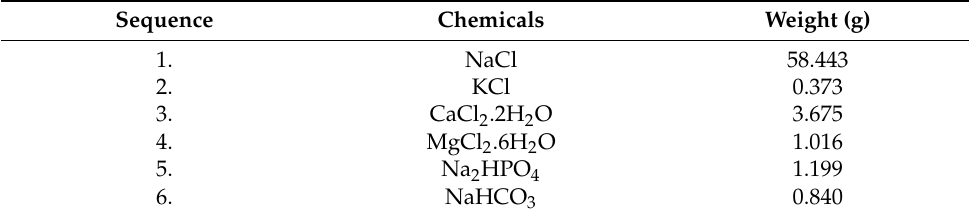
Table 1. Chemicals and their sequence of addition for the preparation of 10 × SBF (1